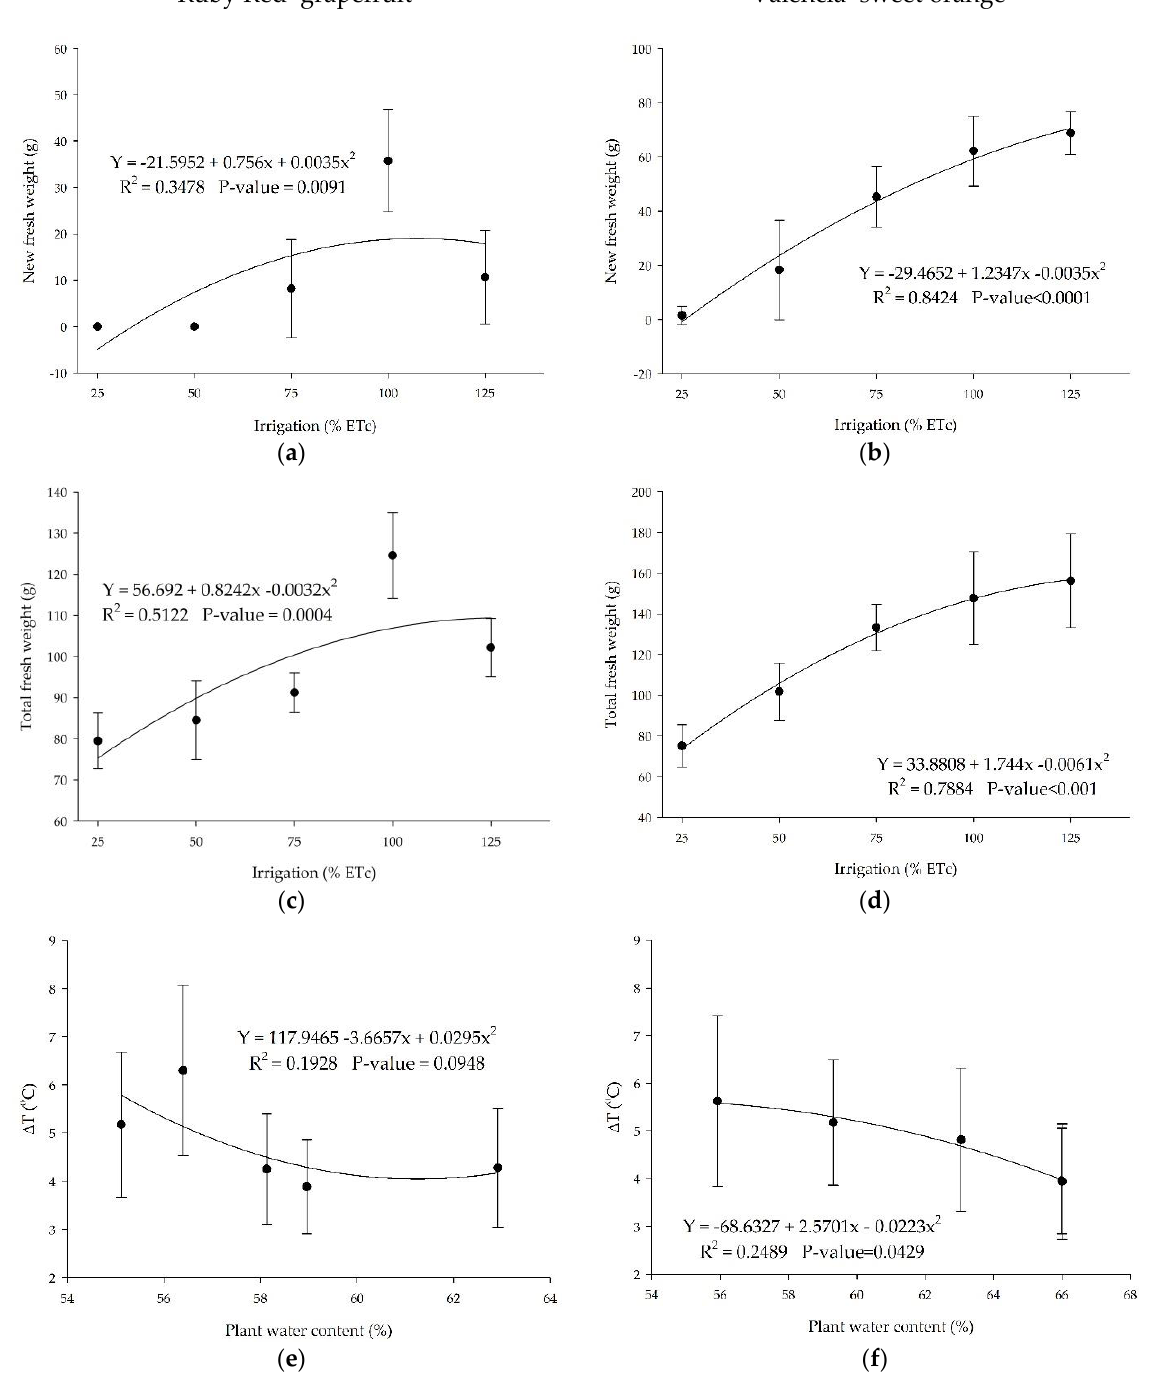
Figure 10. New and total fresh weight and temperature difference (∆T) between the plants and the air in ‘Ruby Red’ grapefruit ( a , c , e ) and ‘Valencia’ sweet orange plants ( b , d , f ). Polynomial models adjusted by regression using data from 5 replications. Each data point is the average ± standard deviation of 5 replications. ETc = crop evapotranspiration.